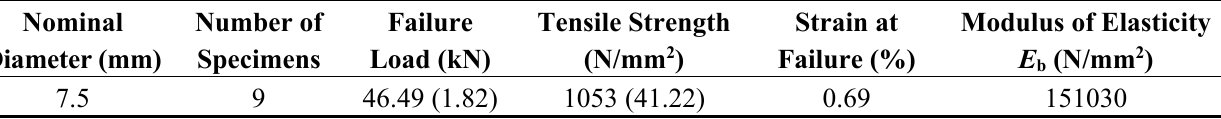
Table 1. Mechanical properties of CFRP bars.